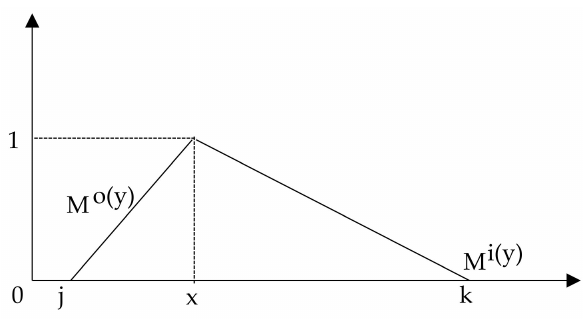
Figure 4. A triangular fuzzy number (TFN).